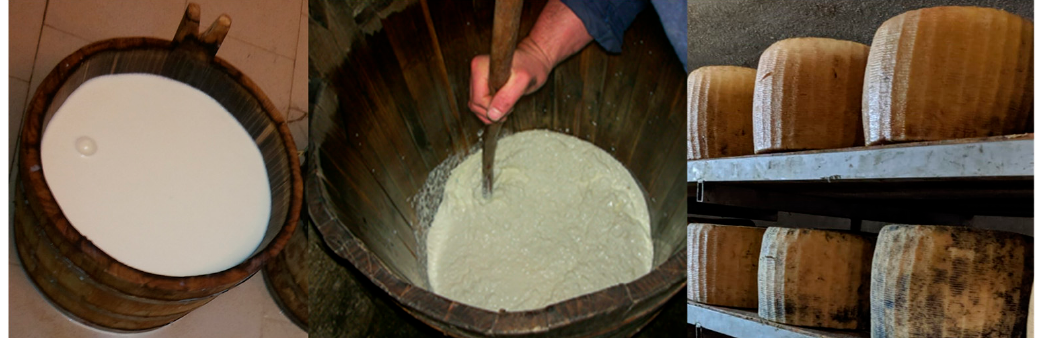
Figure 2. Contact of raw milk and ripened cheeses with wooden equipment during the production of PDO Pecorino Siciliano cheeses.